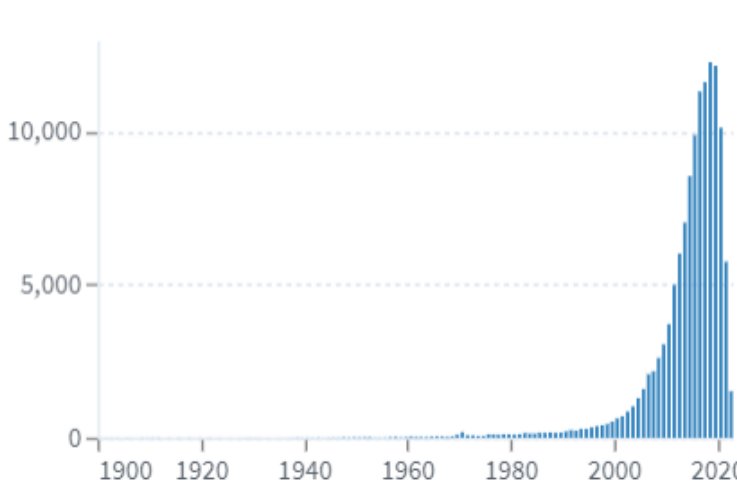
Figure 1: The growing number of scientific publications on STEM education in recent